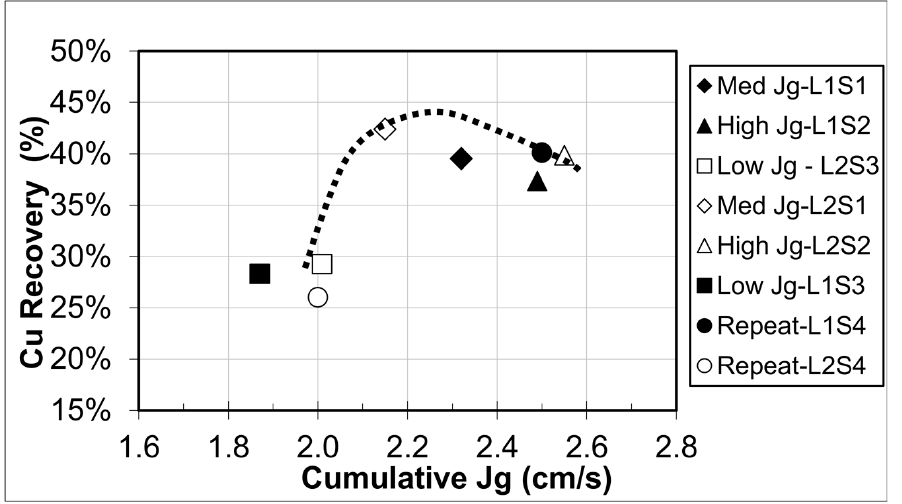
Figure 7. Cu recovery for the first two OK 130 tank cells in the rougher/scavenger circuit. Note that the J g value is combined for the two cells; thus, individual cell J g values are half the value shown. The observation that J g values of around 1 cm/s were found to be near an optimum for recovery in the first two plant OK 130 cells prompted a look into the behavior of the fine end of the bubble size distribution, the <1 mm fraction, as applied to the data. Figure 8 shows the percentage of <1 mm bubbles as a function of J g for the plant and pilot cells.